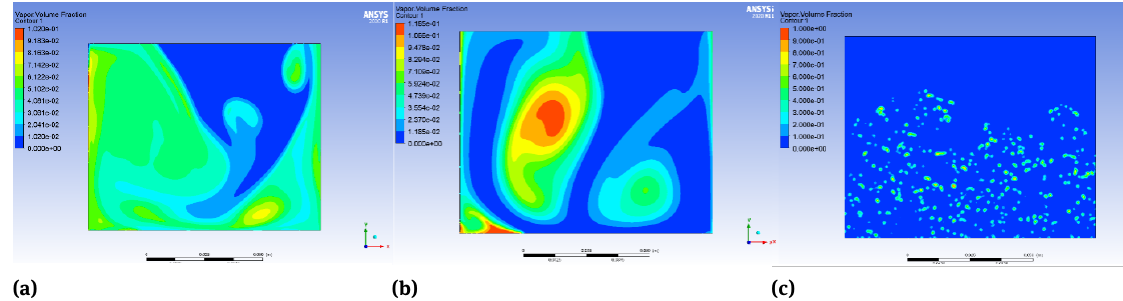
Figure 6: Volume fraction in 4 s. (a) Eulerian; (b) mixture; (c) VOF